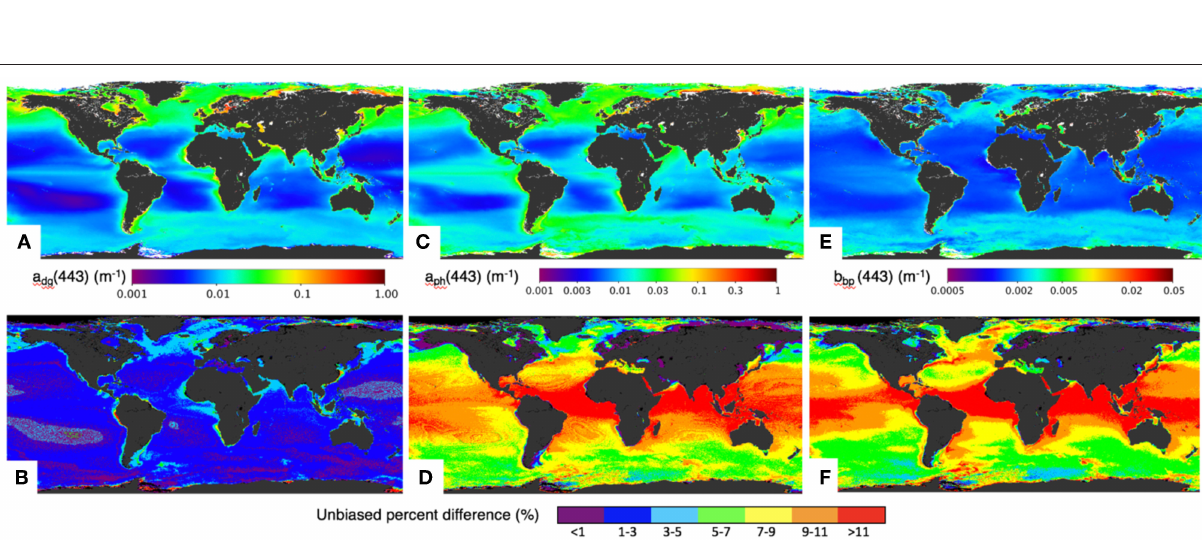
Frontiers in Earth Science | www.frontiersin.org